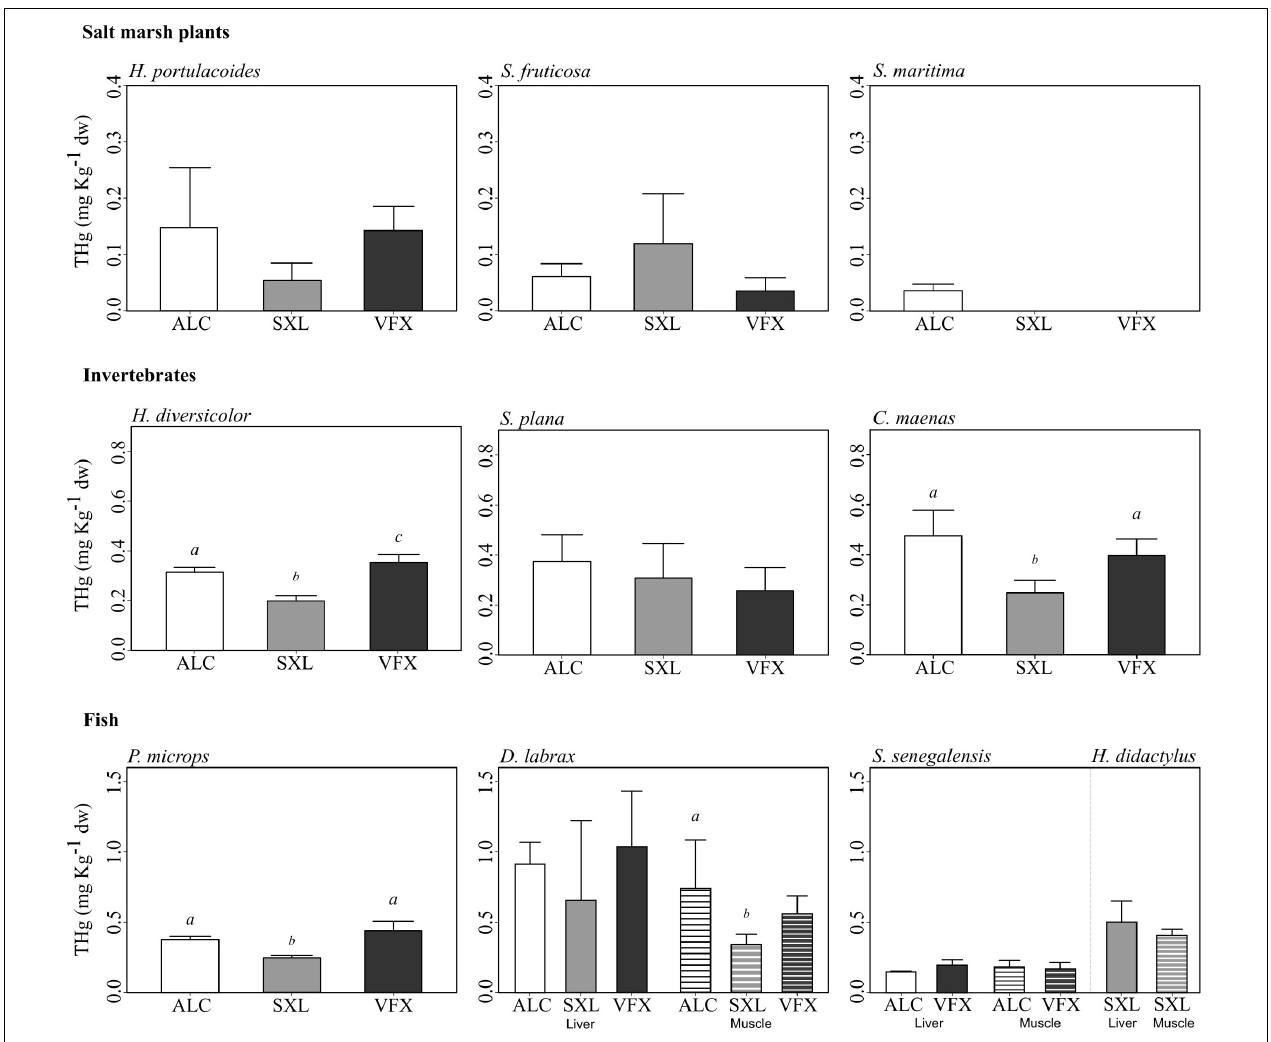
FIGURE 2 | Mean total mercury (THg) concentration (mg kg − 1 dry weight) and standard deviation in salt marsh plants, invertebrates and fish species collected in three sites in the Tejo estuary ( n = 3 to 5 replicate samples per species, tissue and site). Hediste diversicolor and Pomatoschistus microps were analyzed as whole individuals (due to small size), whilst roots, digestive gland, muscle and liver were sampled in plants, other invertebrate and fish species, respectively. In fish, solid bars and line patterns represent liver and muscle concentrations, respectively. Different letters indicate significant differences in THg tissue concentration among sites per species. For trophic levels see Table 2